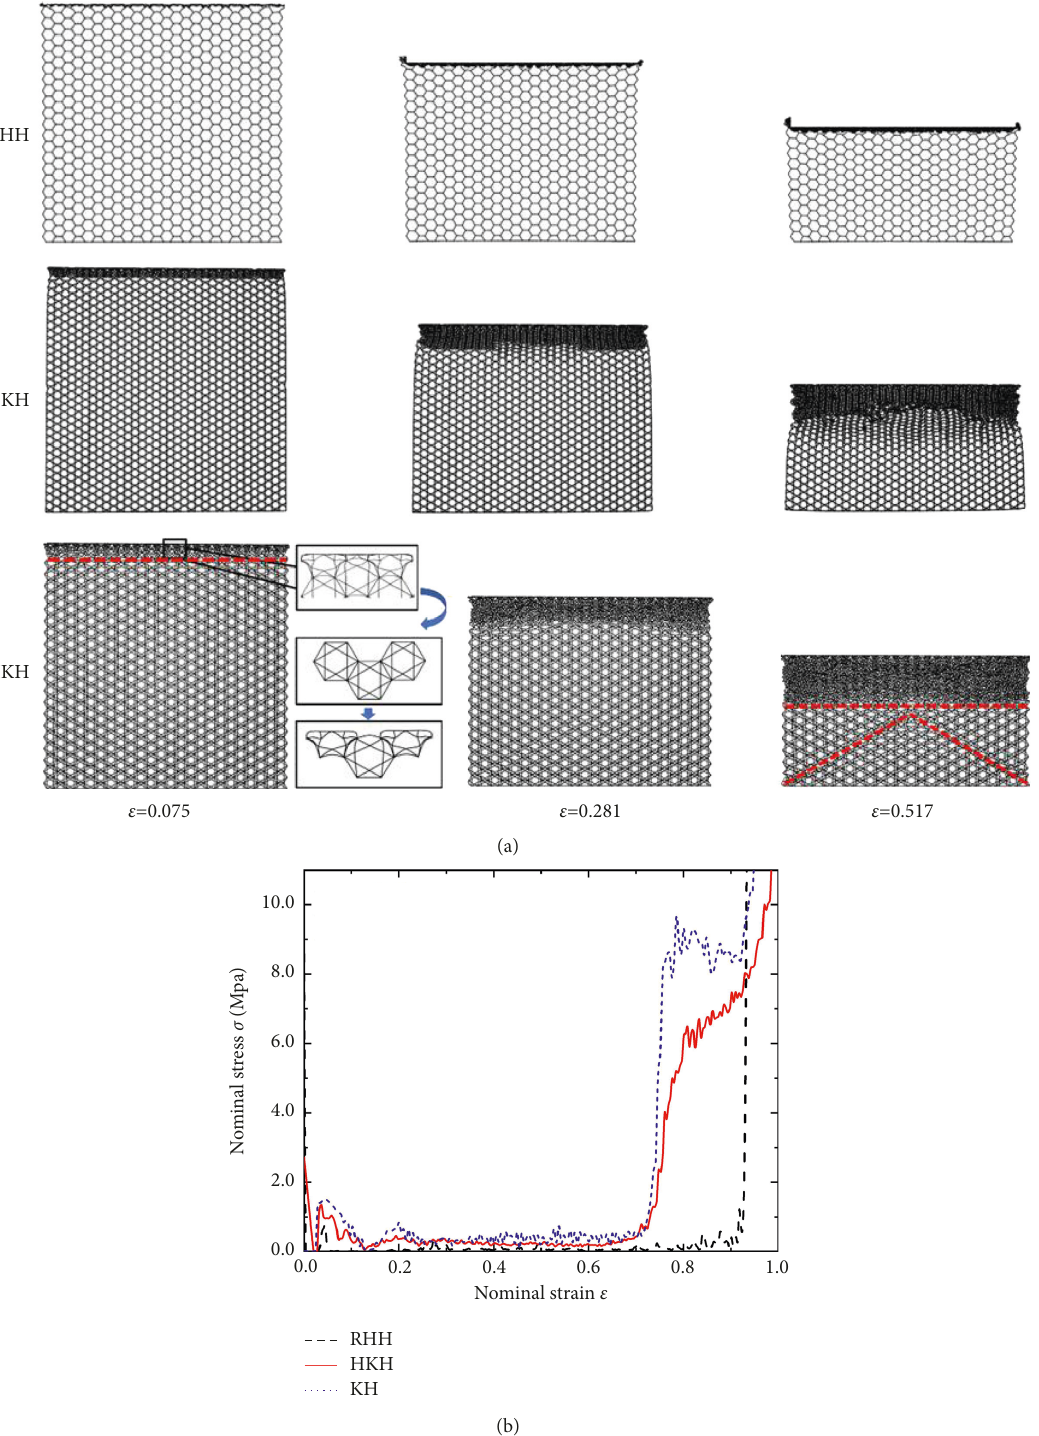
Figure 7: Dynamic crushing behaviors of three honeycombs under an impact velocity of V � 100m/s: (a) deformation maps and (b) strain- stress curves. Deformation mechanism of novel combined honeycomb